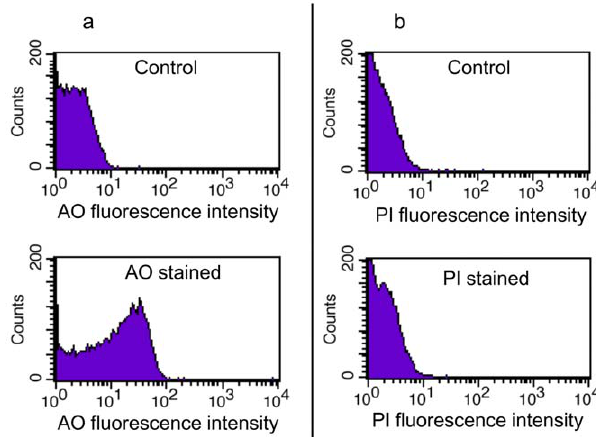
Figure 3. Flow cytometry of DNA-stained microvesicles/exo- somes. A) Enhanced fluorescence at the 530 6 15 nm channel of membrane permeable acridine orange-stained microvesicles/exosomes (below) in comparison with unstained microvesicles/exosomes (above). B) Weak or no fluorescence at 670 nm/LP channel of membrane impermeable propidium iodide-stained microvesicles/exosomes (be- low) not differing from unstained microvesicles/exosomes (above).